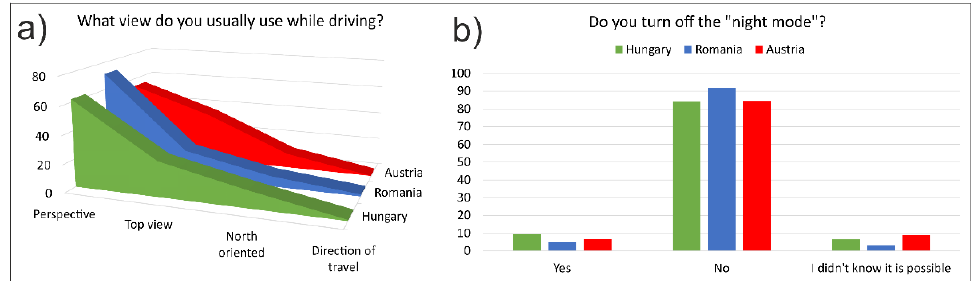
Figure 5. Answers about the ( a ) view and ( b ) night mode.